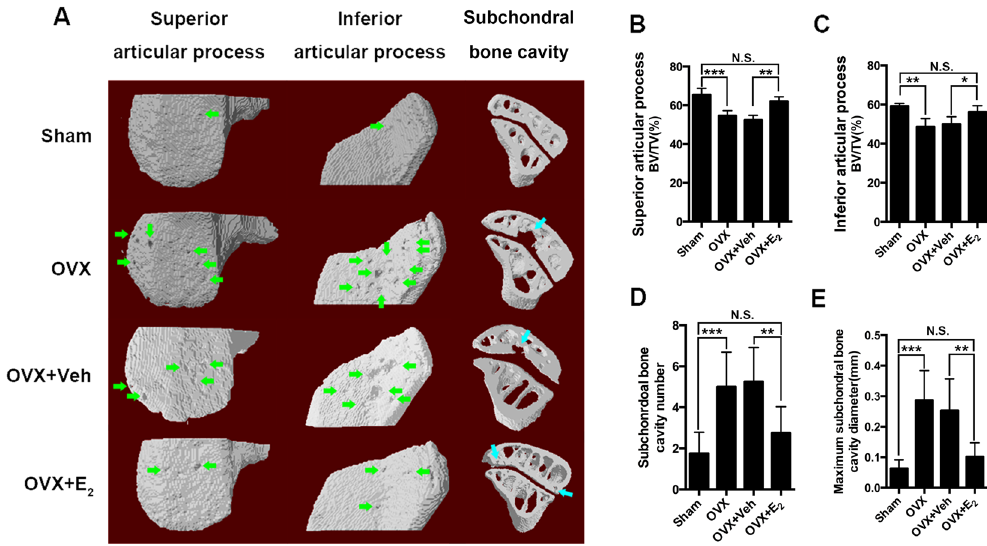
Figure 1. Estrogen deficiency leads to LFJ subchondral bone collapse. ( A ) Representative 3-dimensional and 2-dimensional micro-CT images of the LFJ subchondral bone in different groups. Abundant subchondral bone cavities (green and blue arrows) are shown in OVX and OVX + vehicle (Veh)-treated groups. ( B ) Superior bone volume/tissue volume (BV/TV) of LFJ subchondral bone. ( C ) Inferior BV/TV of LFJ subchondral bone. ( D ) LFJ subchondral bone cavity numbers in different groups. ( E ) LFJ subchondral bone maximum diameters